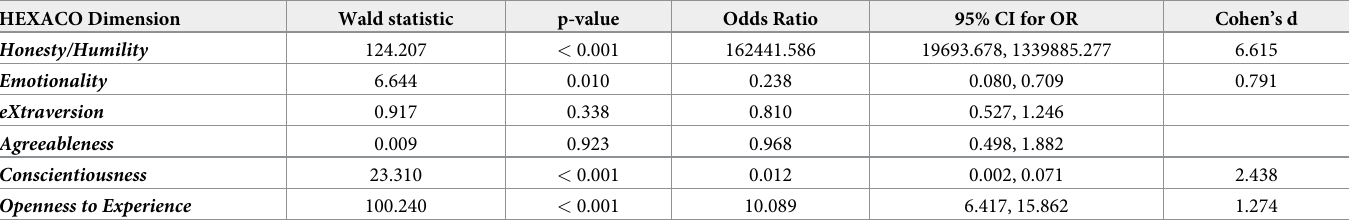
Table 4. Odds of challenge volunteer membership by HEXACO dimension using logistic regression model, adjusted for gender, age, education, country of residence and income. HEXACO Dimension